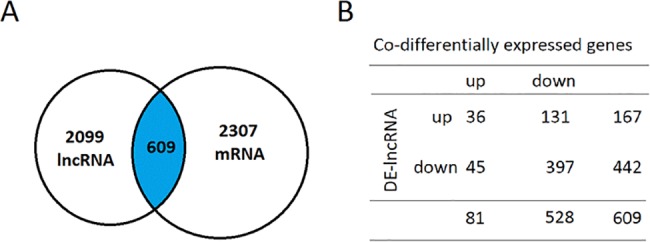
Expression relationship of DE-lncRNA-associated coding genes (distance<100kb) and DE-mRNAs in RA.(A) The crossover of DE-lncRNA-associated coding genes with DE-mRNAs. (B) The table lists the expression correlation of DE-lncRNAs and their neighboring coding genes.